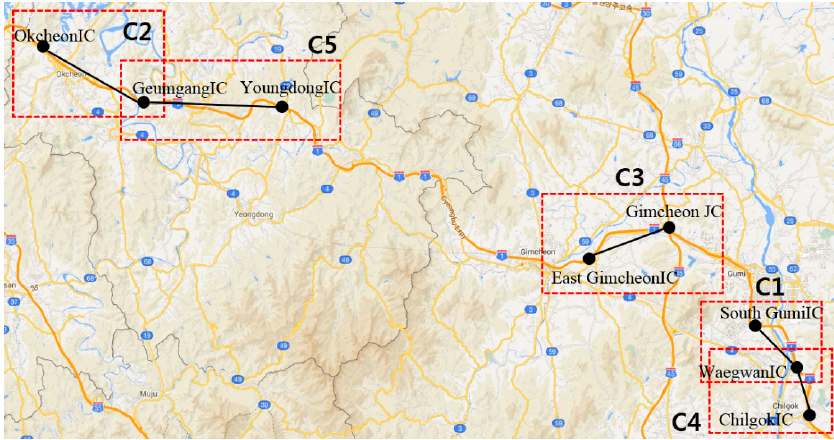
Figure 6. Korean expressways.